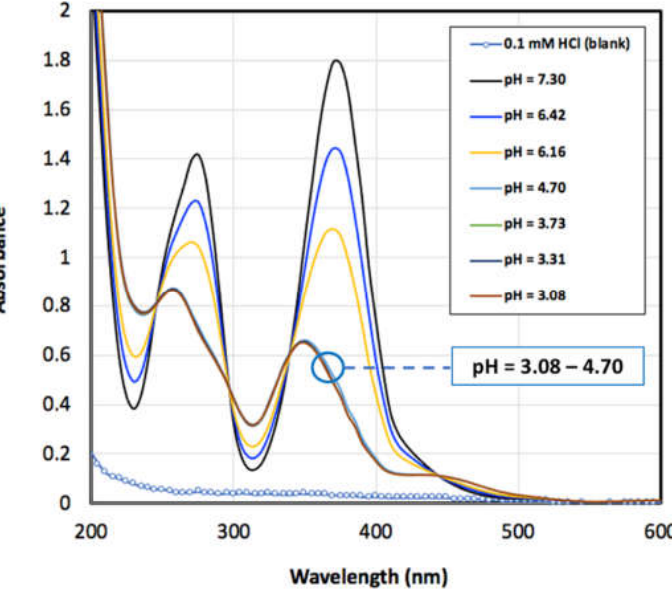
Figure 4. Effect of solution pH on the UV–Vis spectrum of a 0.37 mM Cr(VI) standard solution (as Na 2 CrO 4 ). Samples in the pH 3.08–4.70 range have overlapping UV–Vis spectra.